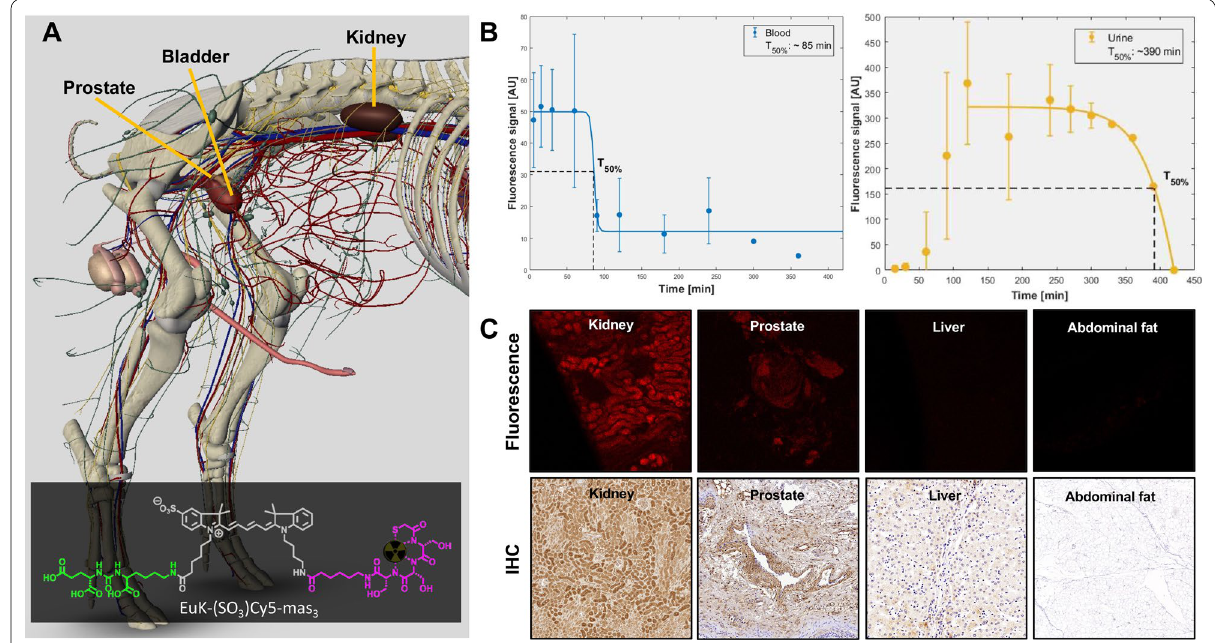
Fig. 1 Excretion of EuK ‐ (SO 3 )Cy5 ‐ mas 3 in a porcine model. A Anatomical overview of vascular and urinary tract (with location of kidney, bladder, and prostate (basal PSMA expression) highlighted). Image was created using 3D-pig-anatomy software from Biosphera. Insert: Structure of EuK ‐ (SO 3 )Cy5 ‐ mas 3 [25] with the Euk targeting moiety highlighted in green, the bridging (SO 3 )Cy5 dye in gray and the mas 3 chelate in pink. B Excretion of EuK ‐ (SO 3 )Cy5 ‐ mas 3 from the blood (in blue) and urine (in orange) was measured over time after intravenous tracer administration ( T 0– T 420 min). C Fluorescence confocal microscopy images of fresh excised tissue specimens obtained after in vivo imaging (red on black; top = = images per organ) and antibody-based PSMA immunohistochemistry (IHC; bottom images per organ) of these